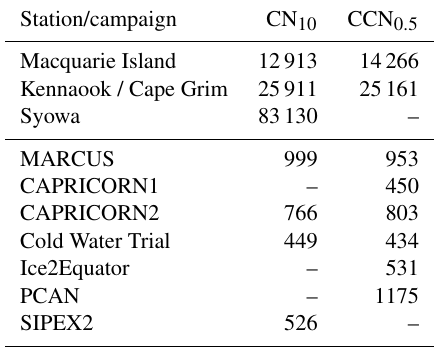
Table 1. Number of hourly observations available from each station or voyage after quality